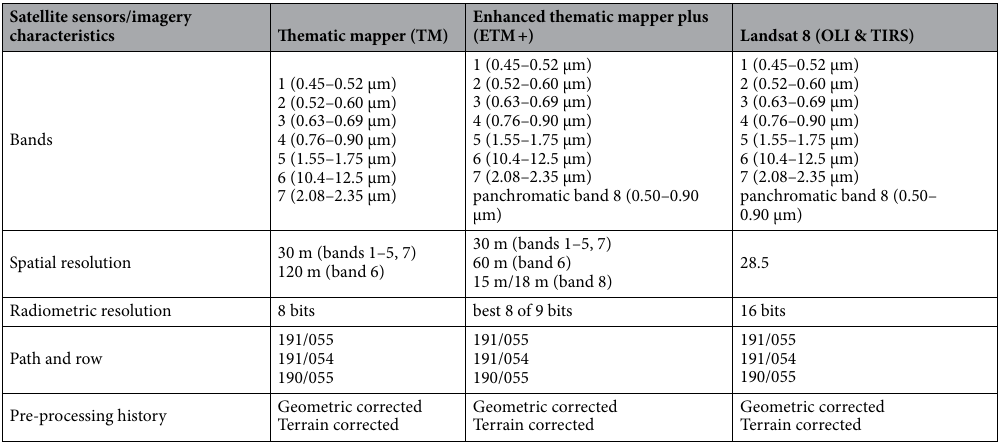
Table 2. Characteristics of the satellite dataset used in the study. The datasets were acquired in December